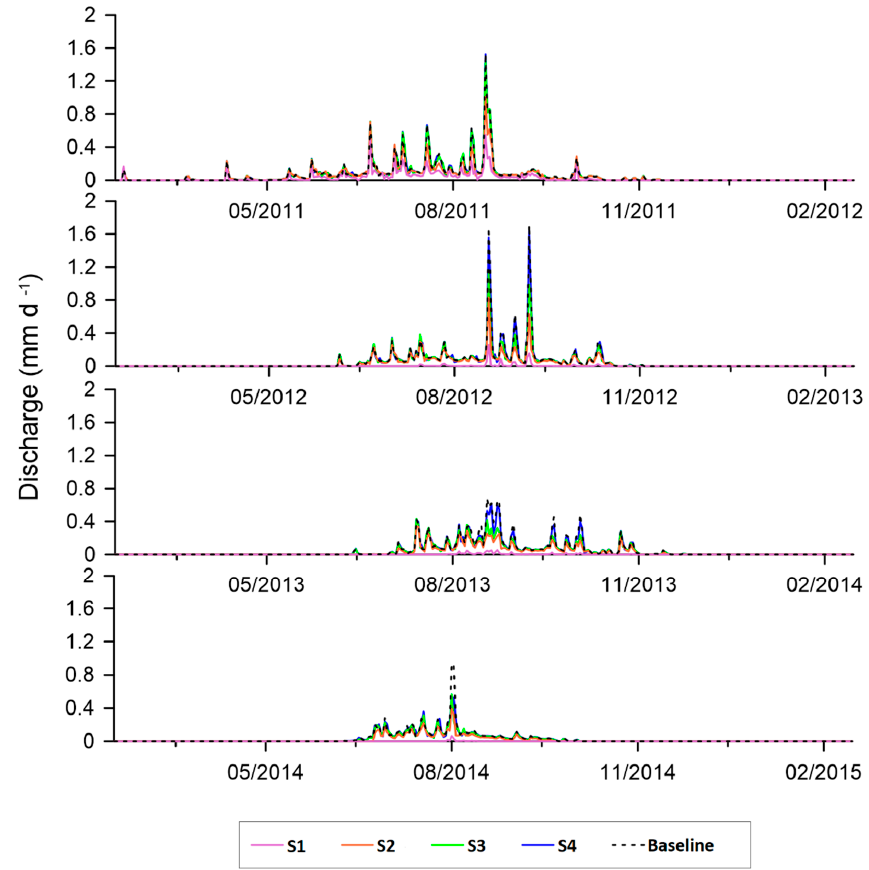
Figure 4. Simulated catchment discharge flow under the baseline and four partial afforestation scenarios between February 2011 and February 2015. Table 4. Comparisons of the mean changes in water balance components from Feb 2011 to Feb 2015.